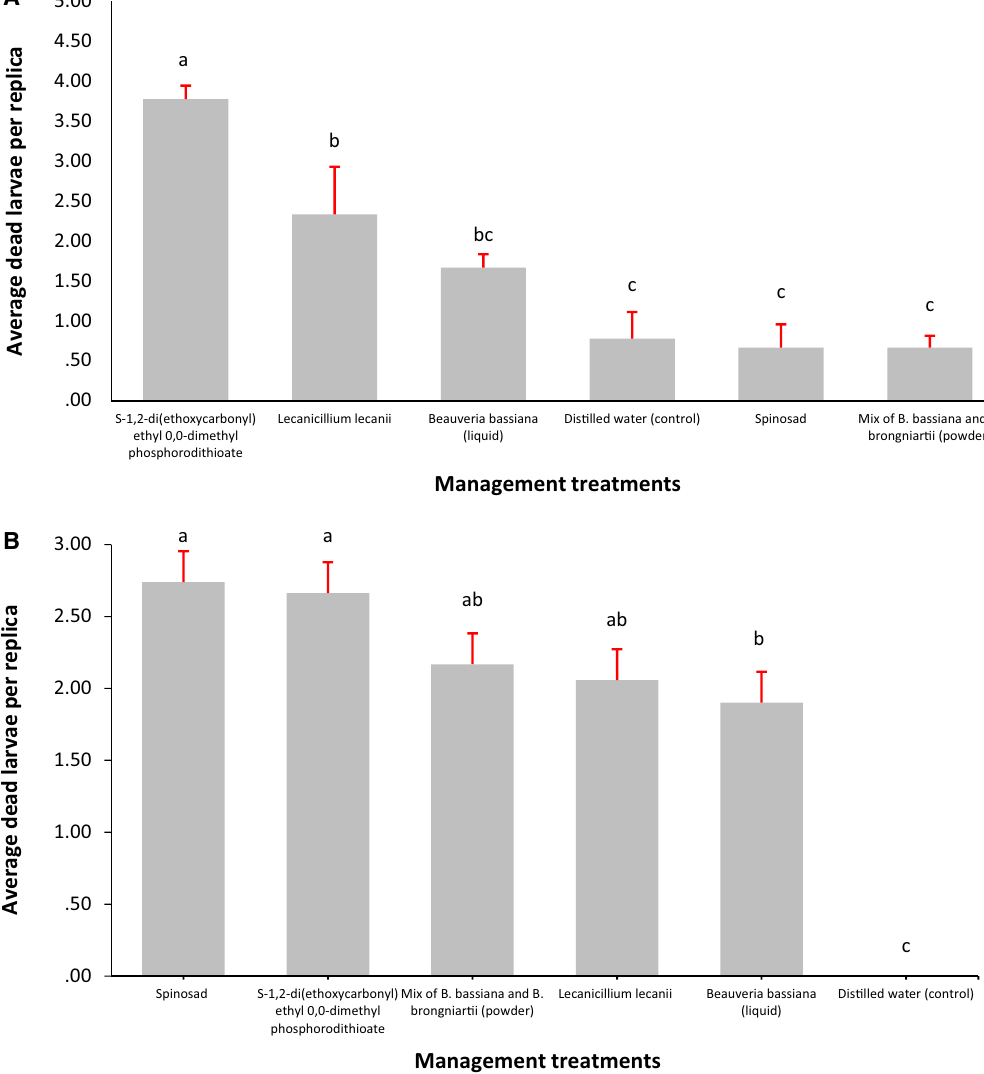
Figure 2. Average number of dead larvae per replicate under laboratory conditions. Different letters indicate statistically significant differences. a C. theobromae and b S. ampliophilobia . Source : Elaborated by the